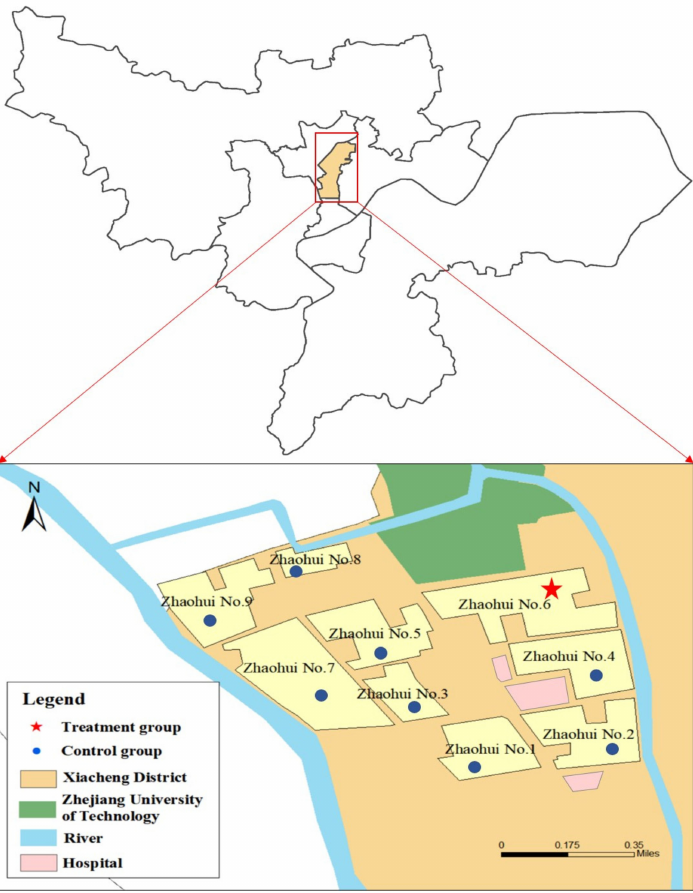
Figure 2. Location of the nine studied residential projects in Zhaohui Street of Hangzhou,